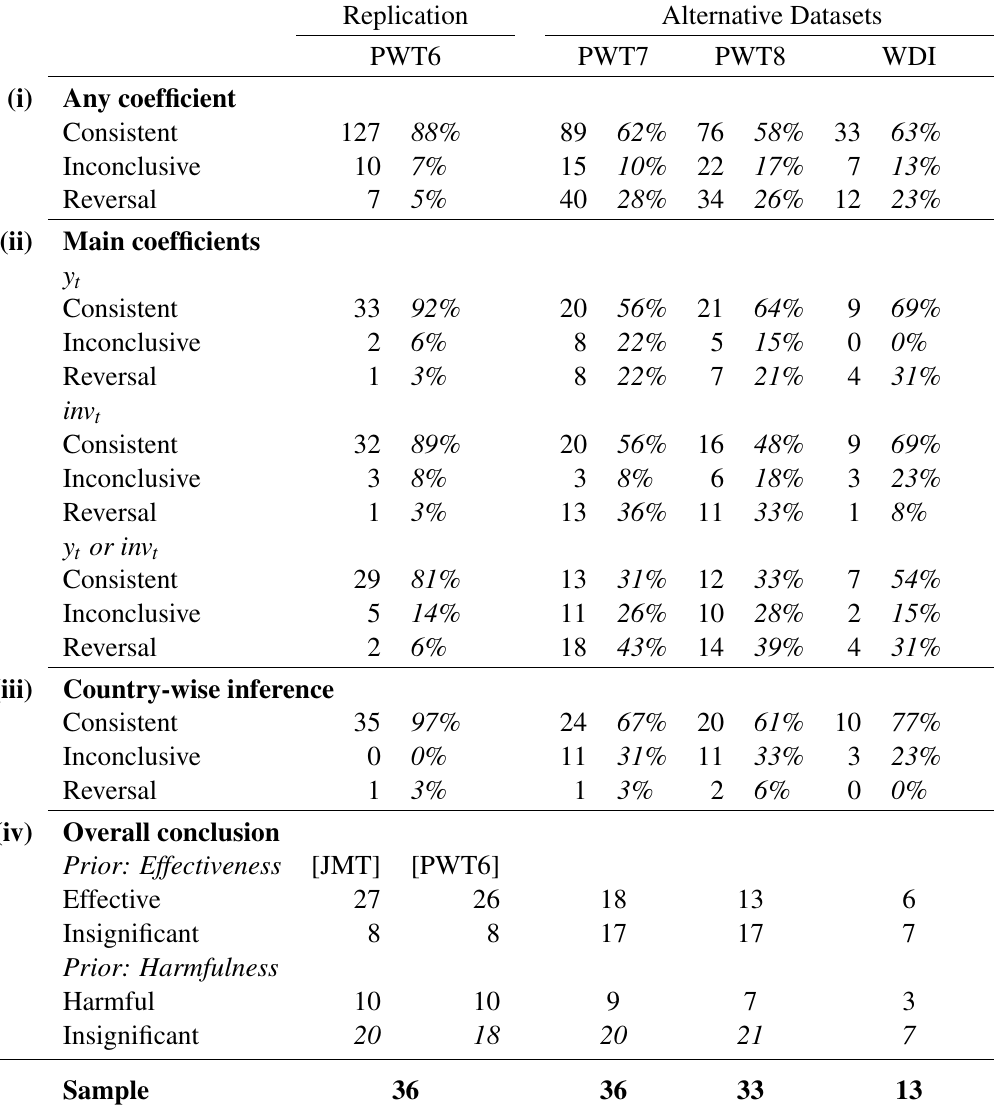
Table 4: Summary of replication